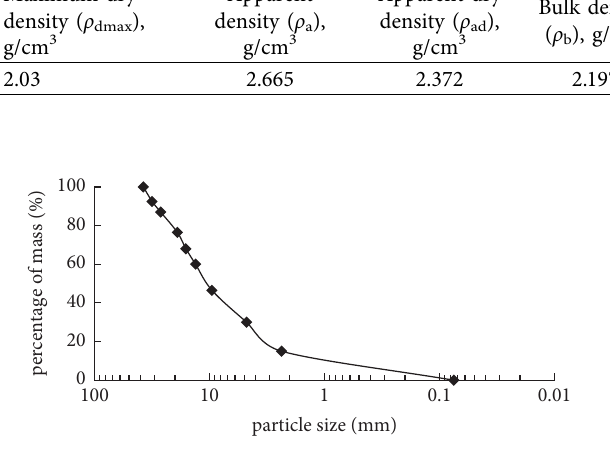
Figure 2: Gradation curve of gangue particles.